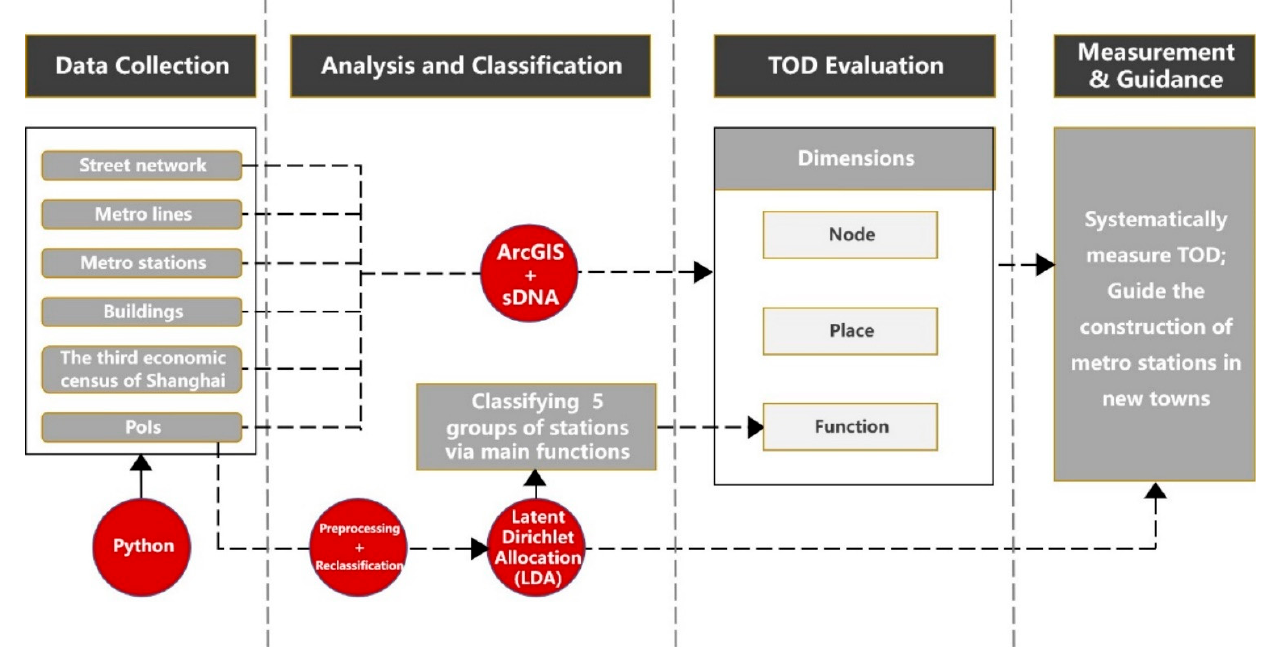
Figure 1. Analytic framework.